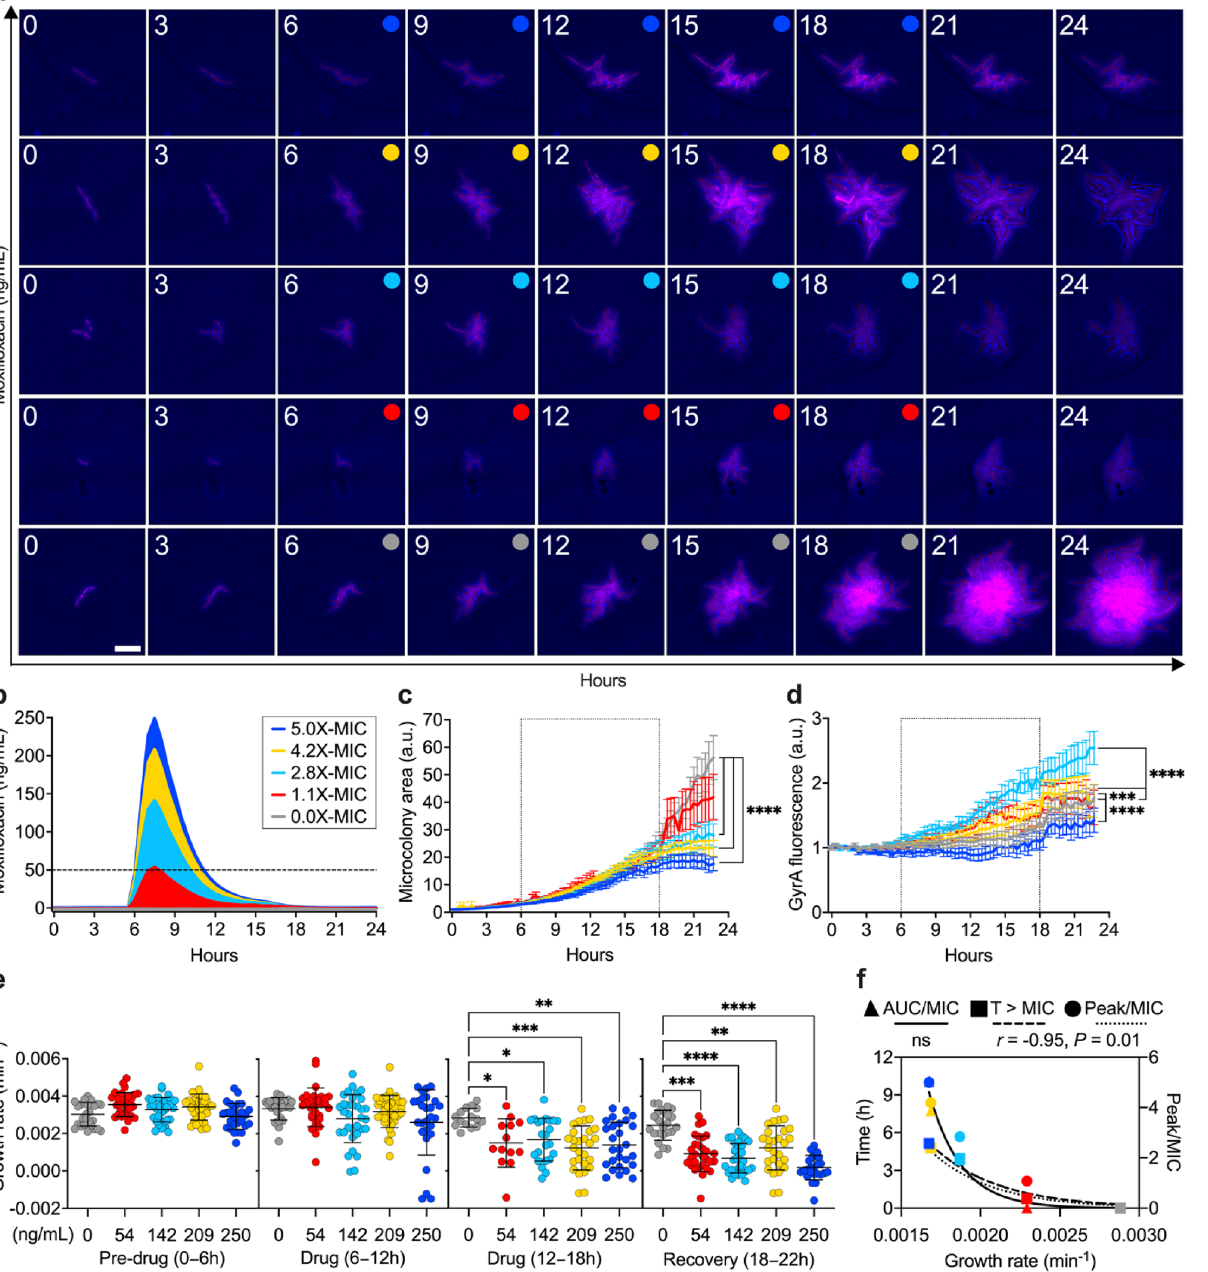
Figure 4. Effect of a pulsing moxifloxacin gradient on M. smegmatis GyrA-mCherry reporter. ( a , b ) Time-lapse microscopy of exponentially growing M. smegmatis seeded into the five-condition device and stressed with a pulsing gradient of moxifloxacin. Time-lapse image series representative of each chamber group ( a ). Phase-contrast and fluorescence images were acquired every 20 min and numbers represent hours. Scale bar 10 µm. Circles indicate the absence or the presence of different drug concentrations, color-coded in ( b ). Concentrations shown in the inset relative to the MIC (dashed line) refer to the peak concentration reached during moxifloxacin exposure, according to the dilution factors measured in Fig. 3c. ( c , d ) Normalized microcolony area ( c ) and GyrA-mCherry fluorescence ( d ). Space between dotted lines indicates drug exposure period. Lines and error bars are color-coded as in ( b ) and represent mean ± SEM (10 ≤ N ≤ 42 microcolonies, from three independent experiments). Significance by 2-way ANOVA followed by Dunnett’s multiple comparisons test: *** P = 0.0005; **** P < 0.0001. ( e ) Microcolony growth rates measured for each condition color-coded as in ( b ), during different experimental phases, before (pre-drug), during (drug) and after moxifloxacin exposure (recovery). Lines and error bars represent mean ± SD (10 ≤ N ≤ 42). Significance by one-way ANOVA followed by Dunnett’s multiple comparisons test: * P = 0.01; ** P = 0.001; *** P = 0.0003; **** P < 0.0001. ( f ) Pearson r correlation between different PK parameters and averaged microcolonies growth rates (10 ≤ N ≤ 42), measured over the entire duration of the experiment, for each condition color-coded as in ( b ). Left y -axis: ratio of area under the concentration–time curve to MIC (AUC/MIC), and time above MIC (T > MIC); right y -axis: ratio of peak concentration to MIC